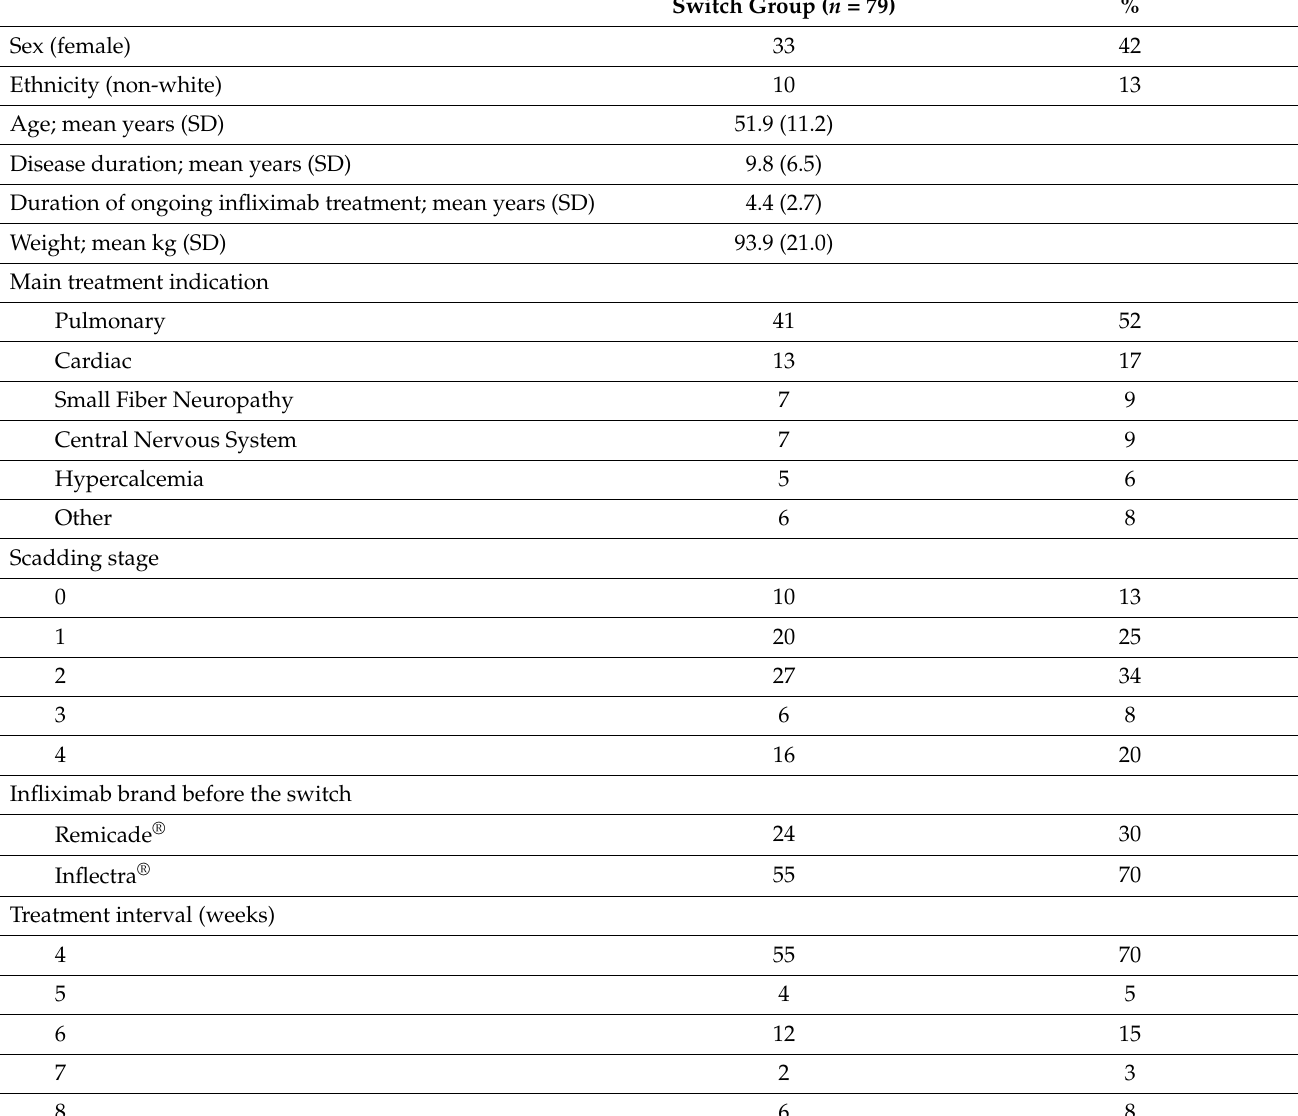
Table 1. Baseline characteristics of sarcoidosis patients at the time of the switch from Remicade ® or Inflectra ® to Flixabi ® . Switch Group ( n = 79) % Sex (female) 33